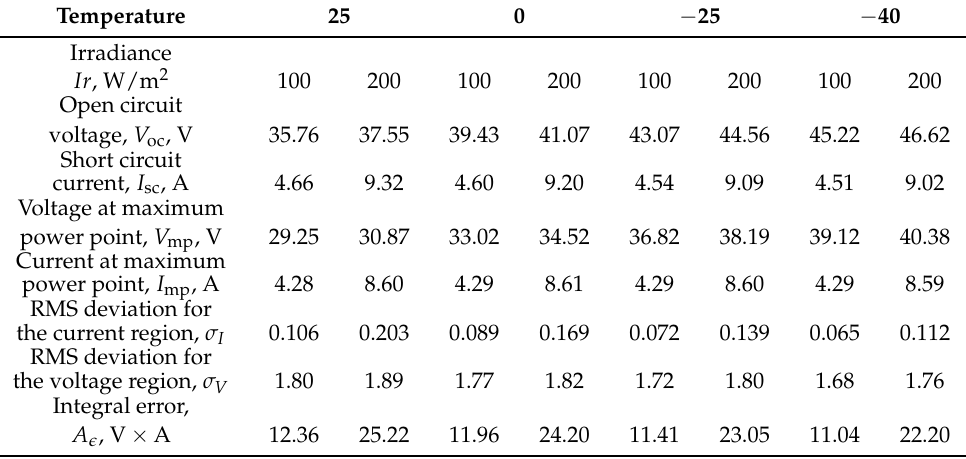
Table 1. Data table for